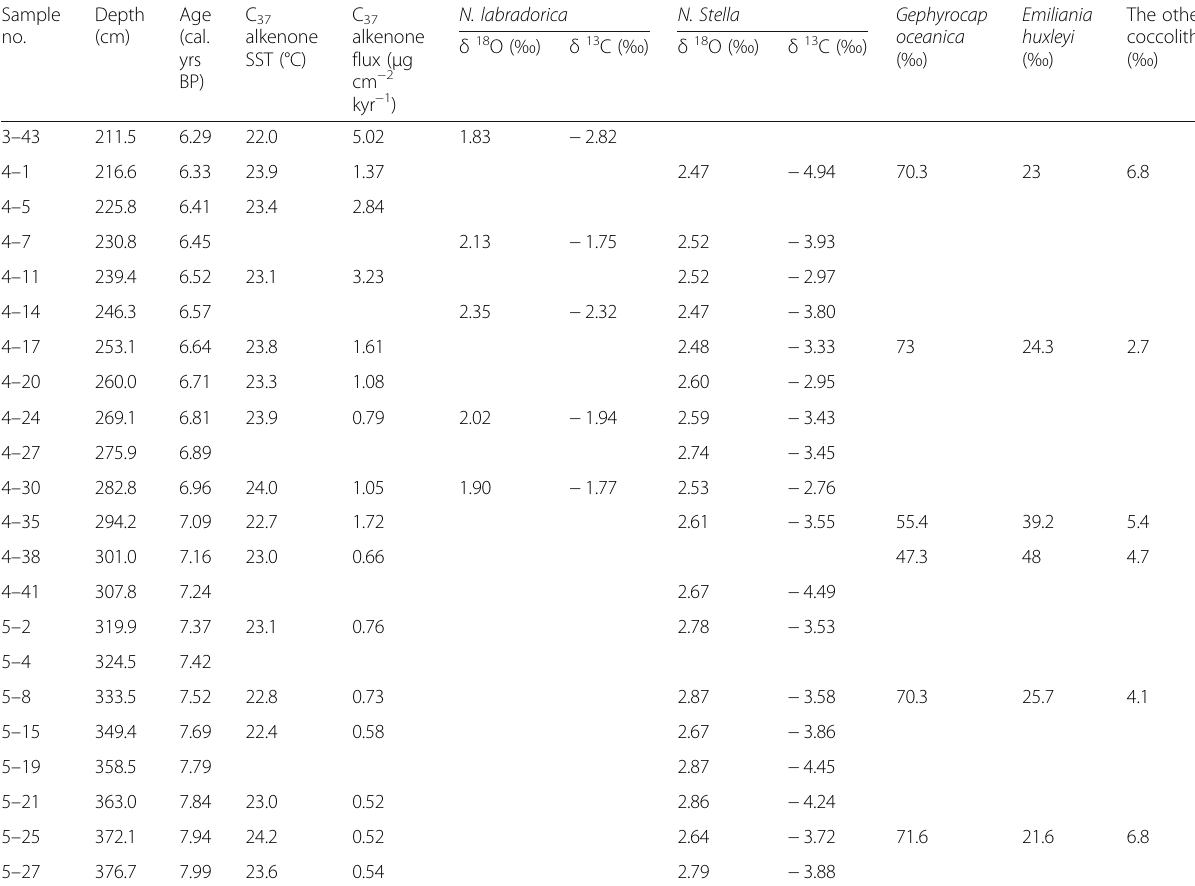
Table 2 Sampled core depths; ages; sea surface temperatures (SST); fluxes of C37 benthic foraminifera; relative abundance of pollens including Castanea , Abies , and Picea ; and relative abundance of coccoliths (Continued) Sample